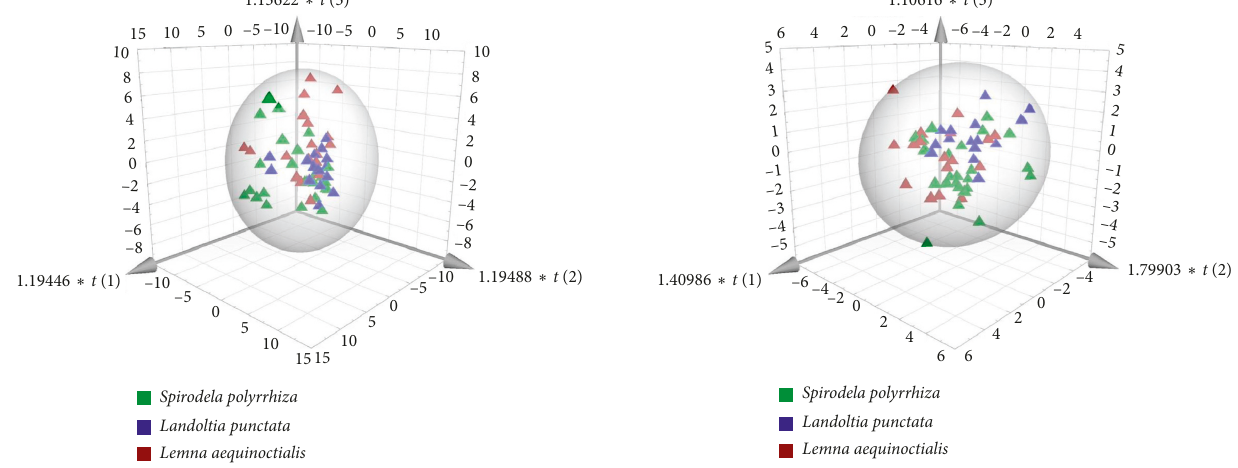
Figure 3: Three-dimensional score plot of orthogonal partial least square-discriminant analysis (OPLS-DA) based on the content of free amino